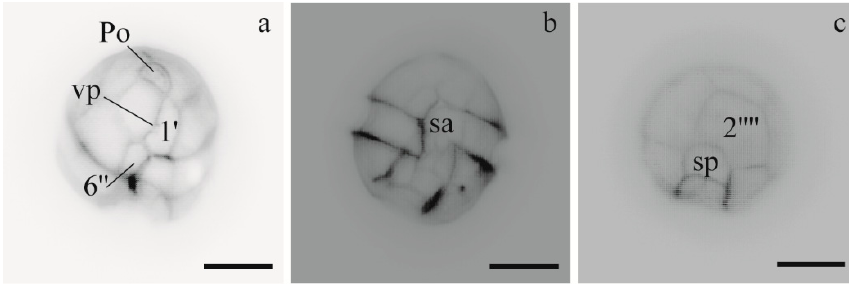
Figure 2. Light micrographs of Alexandrium minutum cells (UNISS3 and UNISS4 strains), stained with Calcofluor and observed using UV fluorescence. ( a , b ) apical and ventral views showing the ventral pore (vp) in the 1 ′ plate and the wide anterior sulcal plate (sa); ( c ) antapical view showing the 2 ′′′′ plate. Scale bars 10 µm.